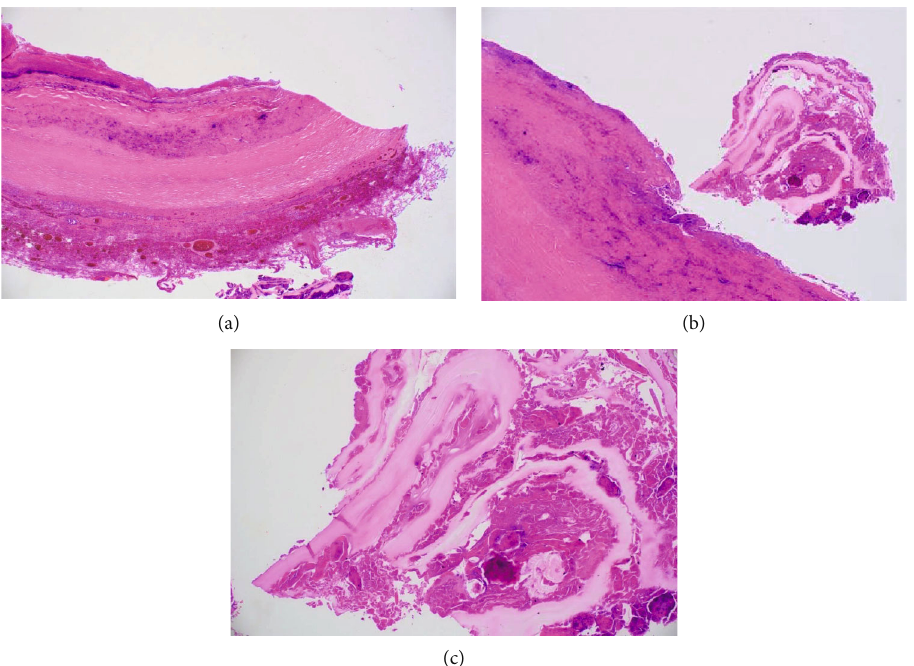
Figure 5: Histopathology images using hematoxylin and eosin (H&E) stains. Low power view (H&E 20x, (a)) shows the thick fi brous capsule with a mixed in fl ammatory in fi ltrate and granulation tissue. Medium power view (H&E 40x, (b)) shows the inner side of the capsule with a laminated cyst wall lining. A higher power view (H&E 200x, (c)) shows the laminated membrane structure. In the cyst wall, some areas demonstrated acellular laminated membranous structures with cellular debris and calci fi cations (b, c). The adjacent lung tissue was congested and showed a chronic in fl ammatory reaction. There were no viable protoscolices in the cyst wall and adjacent